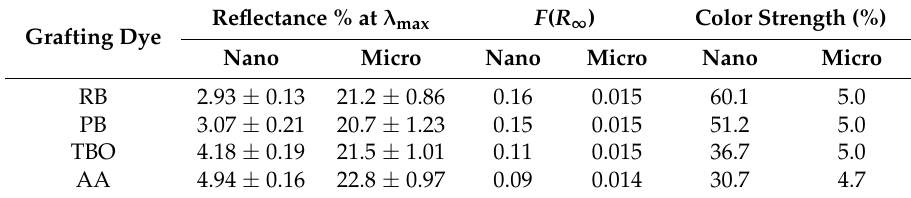
Table 1. Reflectance percentages, K/S values and color strength (%) of nano and micro fabrics grafted with RB, PB, TBO, and AA.